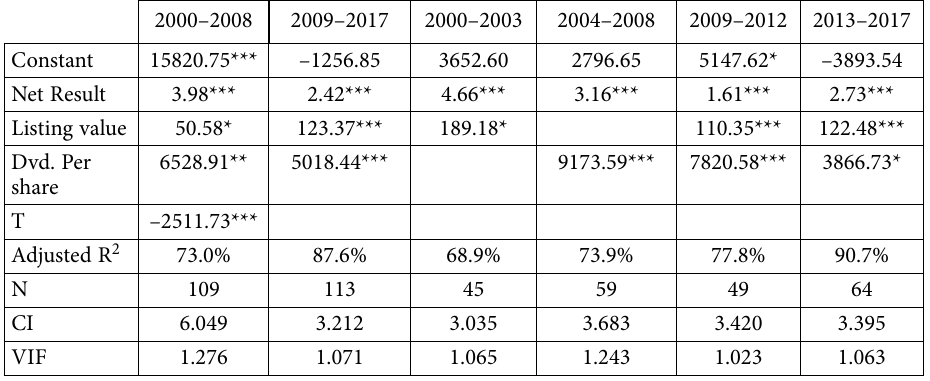
Table 5. Linear regression models by periods for the high-value brands of the IT sector estimated by